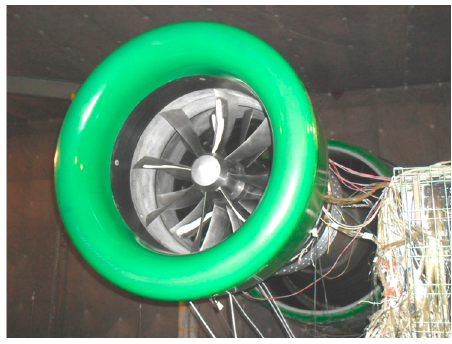
Figure 34. The COBRA1 counter rotating fan installed at the C-3A test facility.